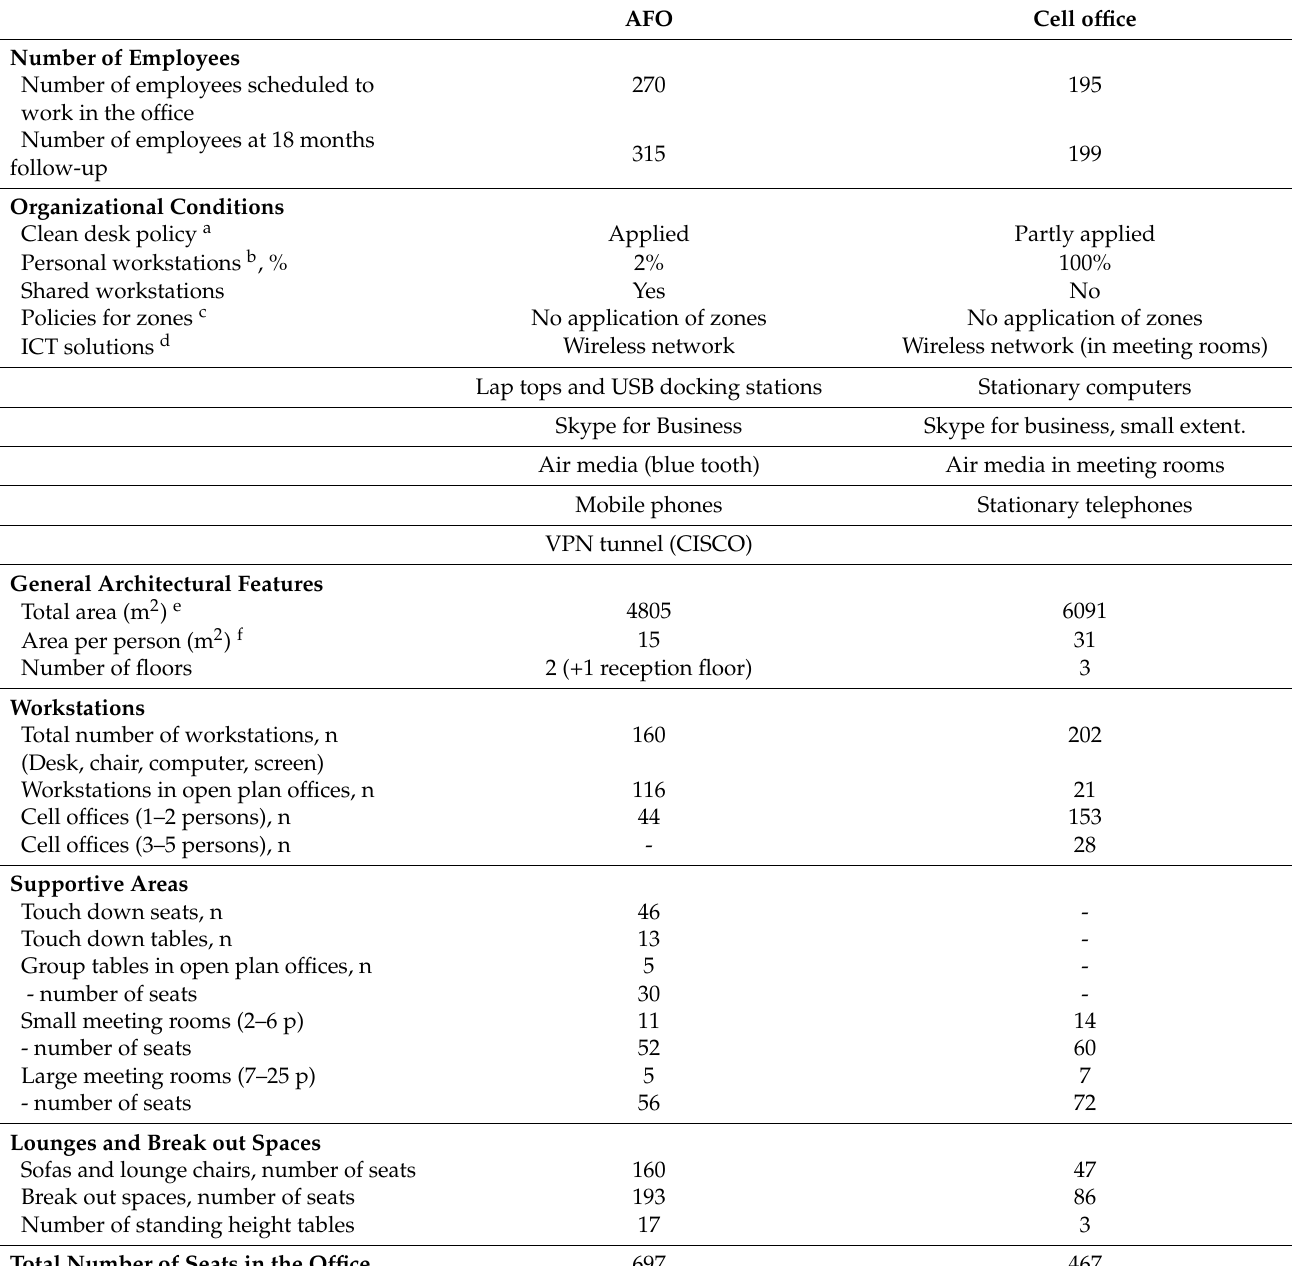
Table A1. Organizational and architectural features in the activity-based flex office (AFO) and cell office, respectively, (18-months follow up)